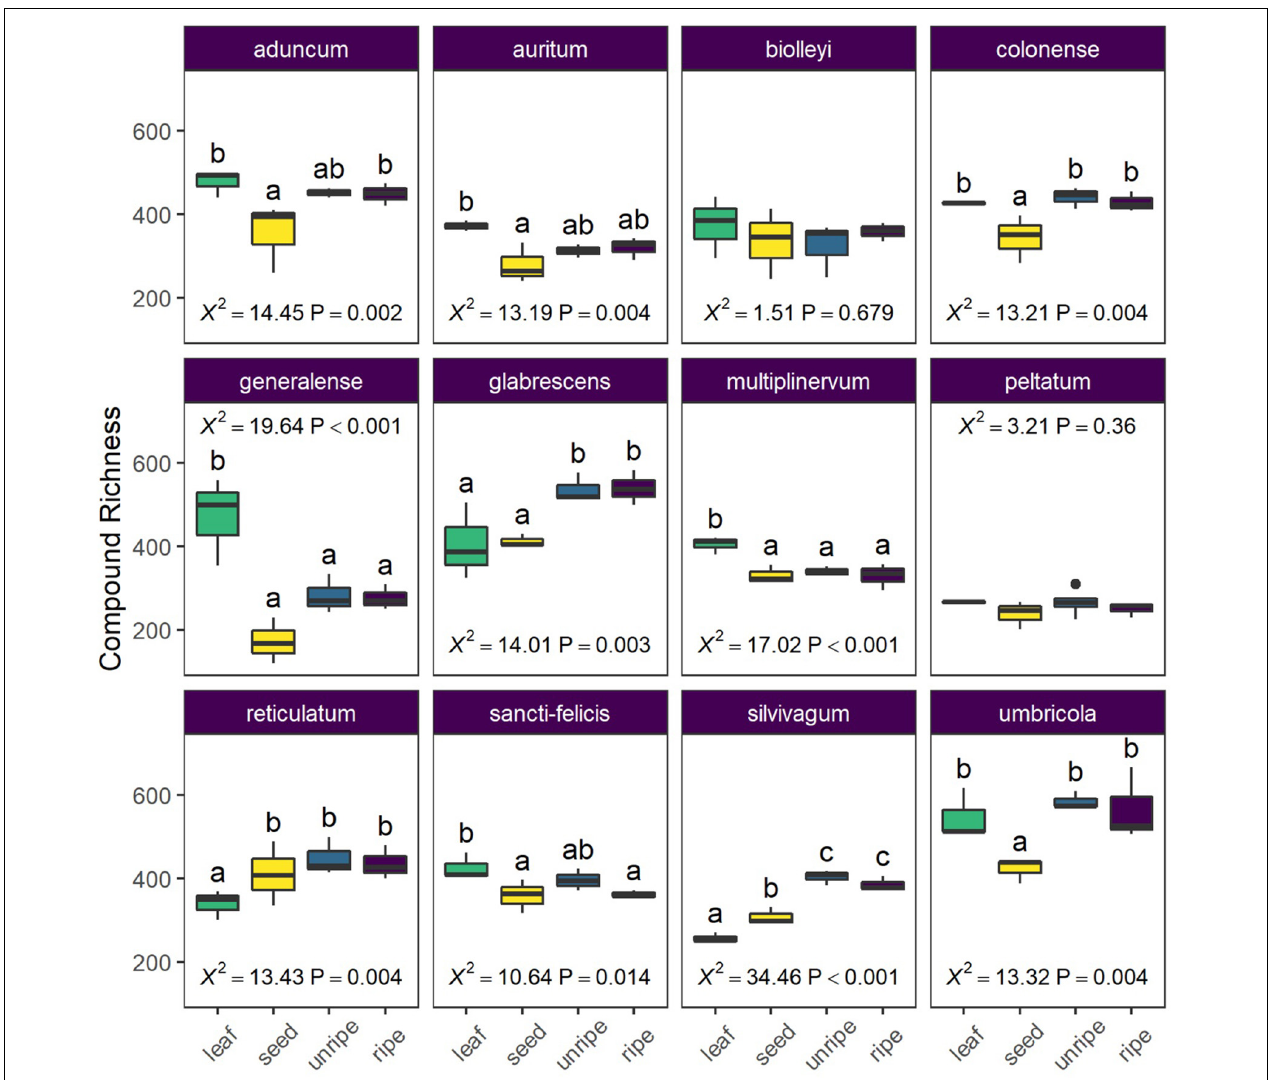
FIGURE 4 | Average chemical richness differs across species and organ type (leaf, seed, unripe pulp, and ripe pulp). Letters indicate results of pairwise Tukey post-hoc comparisons of organs within each species, with non-shared letters indicating a significant difference at P < 0.05. Each species plot includes χ 2 and P -values from species-level